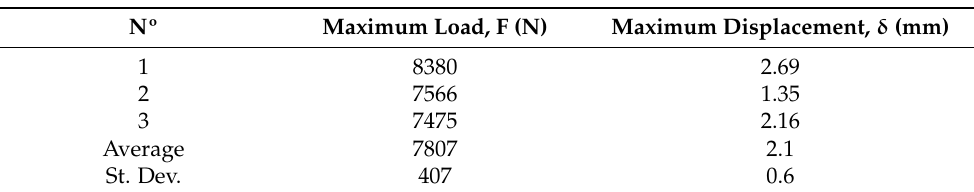
Table 5. Maximum load and displacement at failure for specimens immersed for 900 days, adapted from [60,62,63].